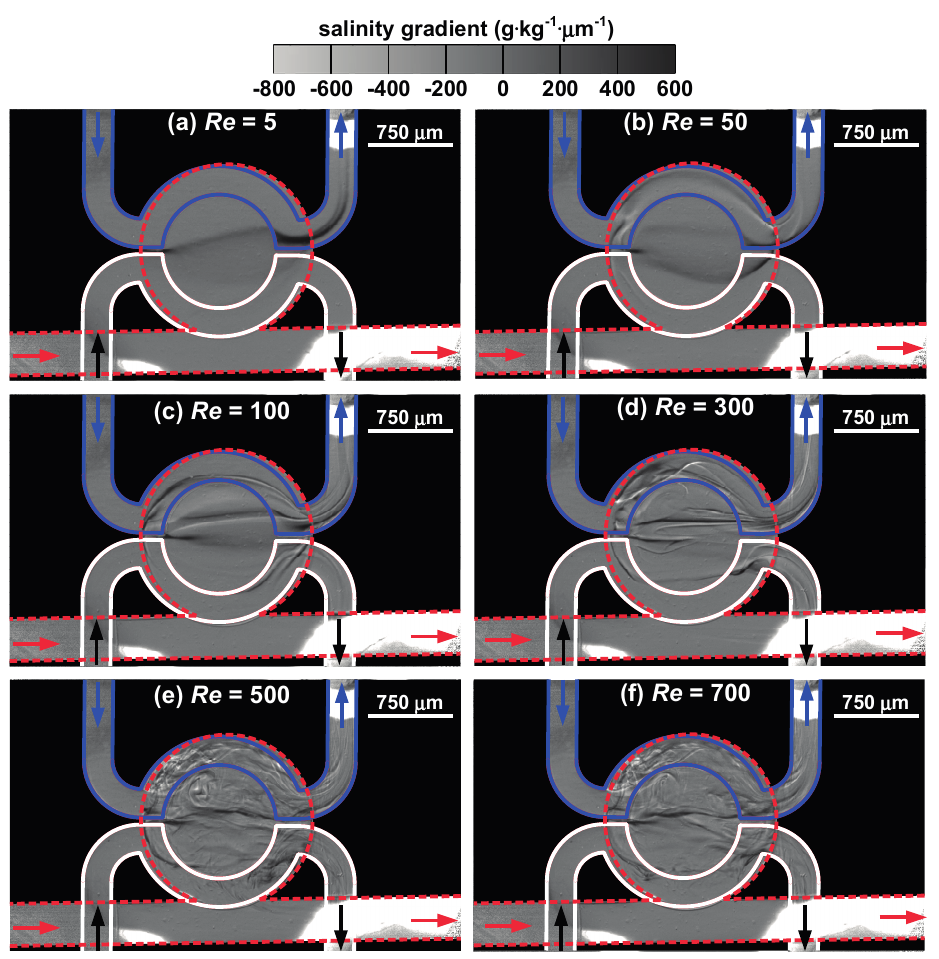
Figure 6. Distribution of salinity gradient in the target microfluidic device under different Reynolds numbers: ( a ) Re = 5, ( b ) Re = 50, ( c ) Re = 100, ( d ) Re = 300, ( e ) Re = 500, and ( f ) Re =